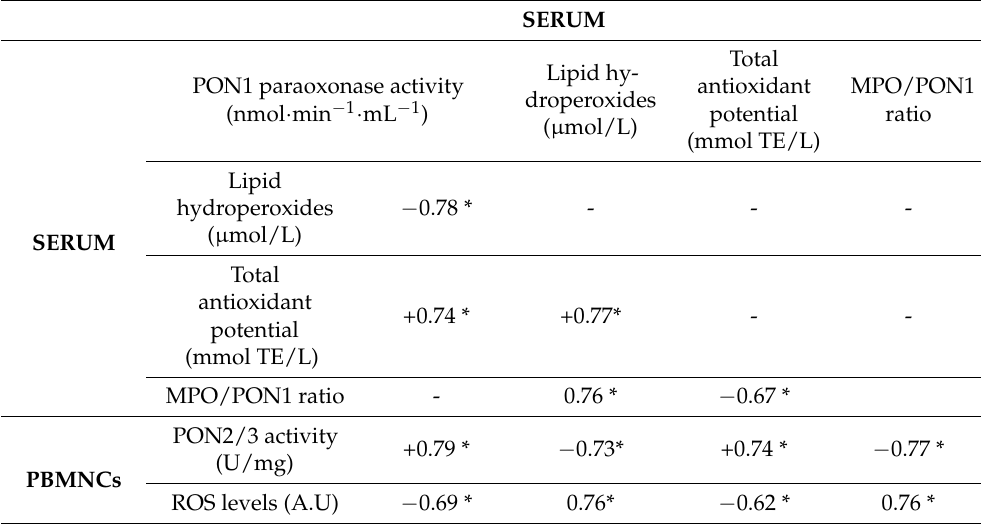
Table 3. Correlations between biochemical parameters evaluated in serum and PBMNCs isolated from children included in the study (control and AD children, n = 104); * p <